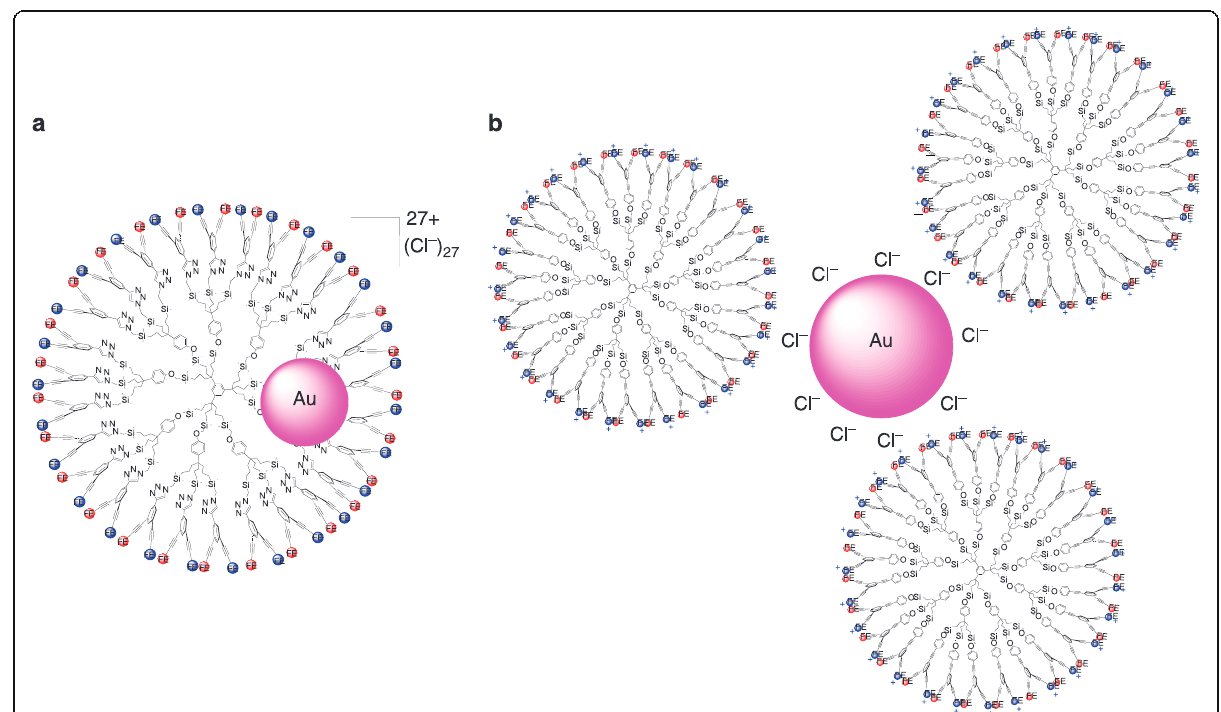
Fig. 6 AuNP syntheses from metallodendrimers. Metallodendrimers containing 54 Cp*Fe(II) dppe redox termini were synthesized by two methods: click coupling between azido-terminated dendrimers forming triazole linkers, ( a ) and Sonogashira coupling that did not provide such intradendritic ligands ( b ). Two reactions of HAuCl 4 were conducted with each of the two dendrimers: 1) reaction with the neutral dendrimers oxidizing them to class-2 mixed-valent polycationic dendrimers; 2) reaction with NaBH 4 in the presence of these class-2 mixed-valent polycationic dendrimers. These two reactions produced AuNPs of closely related sizes, but the click dendrimers yielded small AuNPs inside the dendrimer (1.9 resp. 1.4 nm), whereas the non-click dendrimers yielded large AuNPs (3.7 resp. 3.4 nm). This series of experiments clearly shows the Au(III)-triazole coordination and intra-dendritic triazole stabilization of small AuNPs, whereas these phenomena are not occurring with non-click dendrimers that stabilize large AuNPs only outside dendrimers. Reprinted with permission of ref. [159]. Copyright 2015 Nature publishing